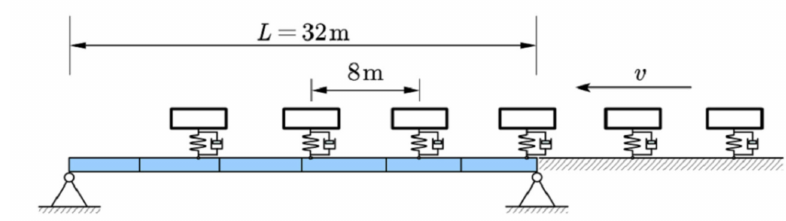
Figure 4. The VBI finite element